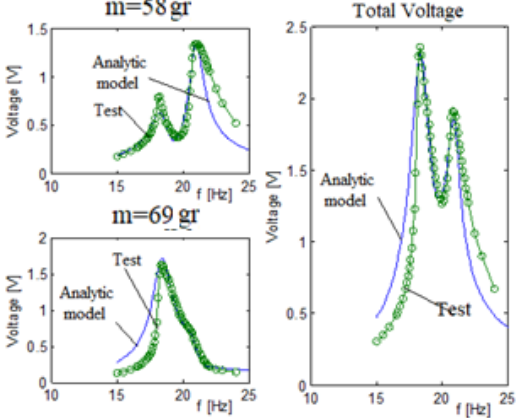
Figure 13. Two bimorphs system voltage—analytical vs. experimental results.